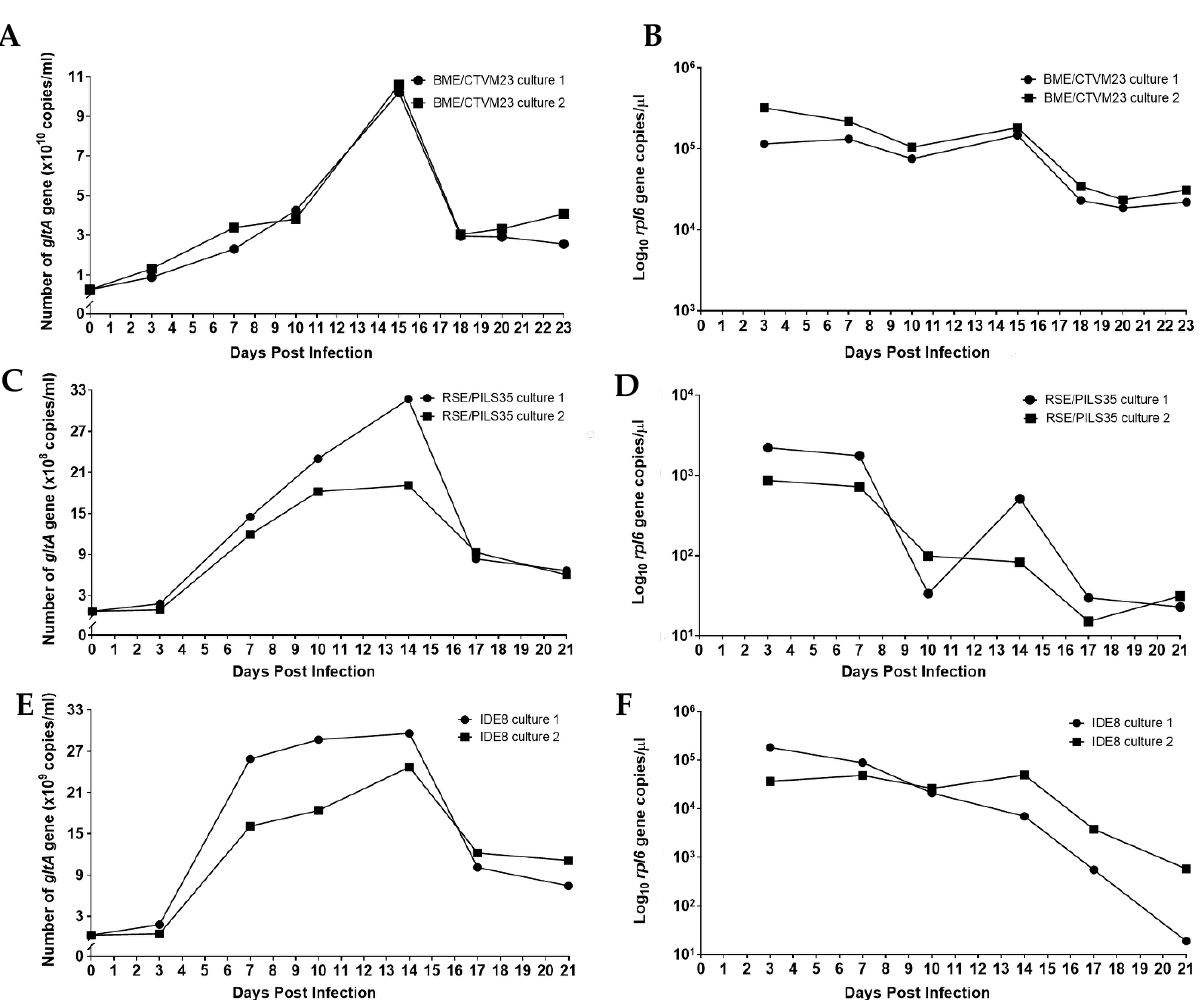
Figure 3. Replication kinetics of Rickettsia raoultii in tick cell lines. The growth curves for R. raoultii were established based on the copy number of rickettsiae-specific gltA gene determined for two replicate cultures each of the tick cell lines BME/CTVM23 ( A ), RSE/PILS35 ( C ) and IDE8 ( E ). Concurrently, the tick cell copy number was determined by amplification of the tick-specific rpl6 gene for each of the BME/CTVM23 ( B ), RSE/PILS35 ( D ) and IDE8 ( F ) cultures.